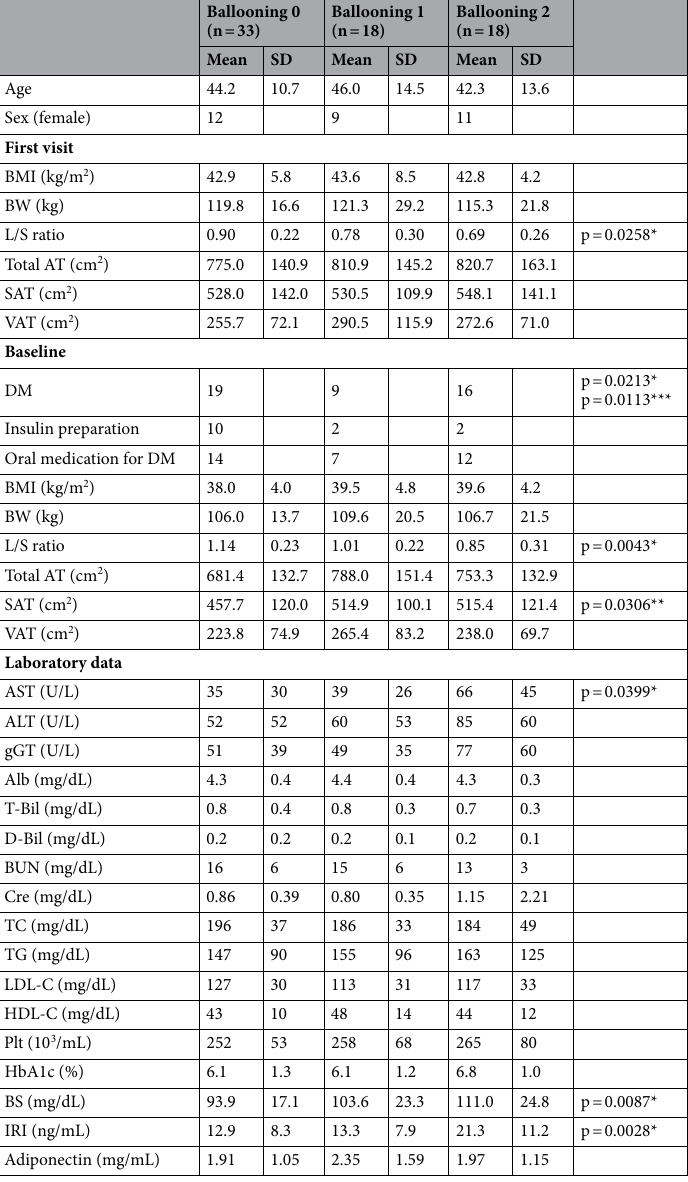
Table 2. Comparison of anthropometric and laboratory data among three groups with different ballooning grades. BMI body mass index; BW body weight; L/S ratio ratio of liver to spleen; AT adipose tissue; SAT subcutaneous adipose tissue; VAT visceral adipose tissue; DM diabetes mellitus; AST aspartate aminotransferase; ALT alanine aminotransferase; gGT gamma glutamyl transpeptidase; Alb albumin; T-Bil total bilirubin; D-Bil direct bilirubin; BUN blood urea nitrogen; Cre creatinine; TC total cholesterol; TG triglyceride; LDL-C low density lipoprotein-cholesterol; HDL-C high density lipoprotein-cholesterol; Plt platelet count; HbA1c hemoglobin A1c and IRI, serum insulin. * and ** indicates statistical significance. * was for ballooning grades 0 vs. 2, ** for grades 0 vs. 1 and *** for grades 1 vs.